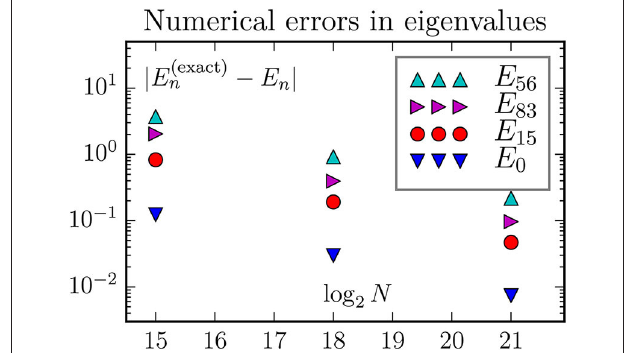
FIGURE 7 | The discretization error of energy eigenvalues when using the standard 7-stensil approximation for the three-dimensional Laplace operator. Exactly, the states E 56 and E 83 are the two edges of a 28-member multiplet with energy 15, and the state E 15 is the middle member of a 10-member multiplet with energy